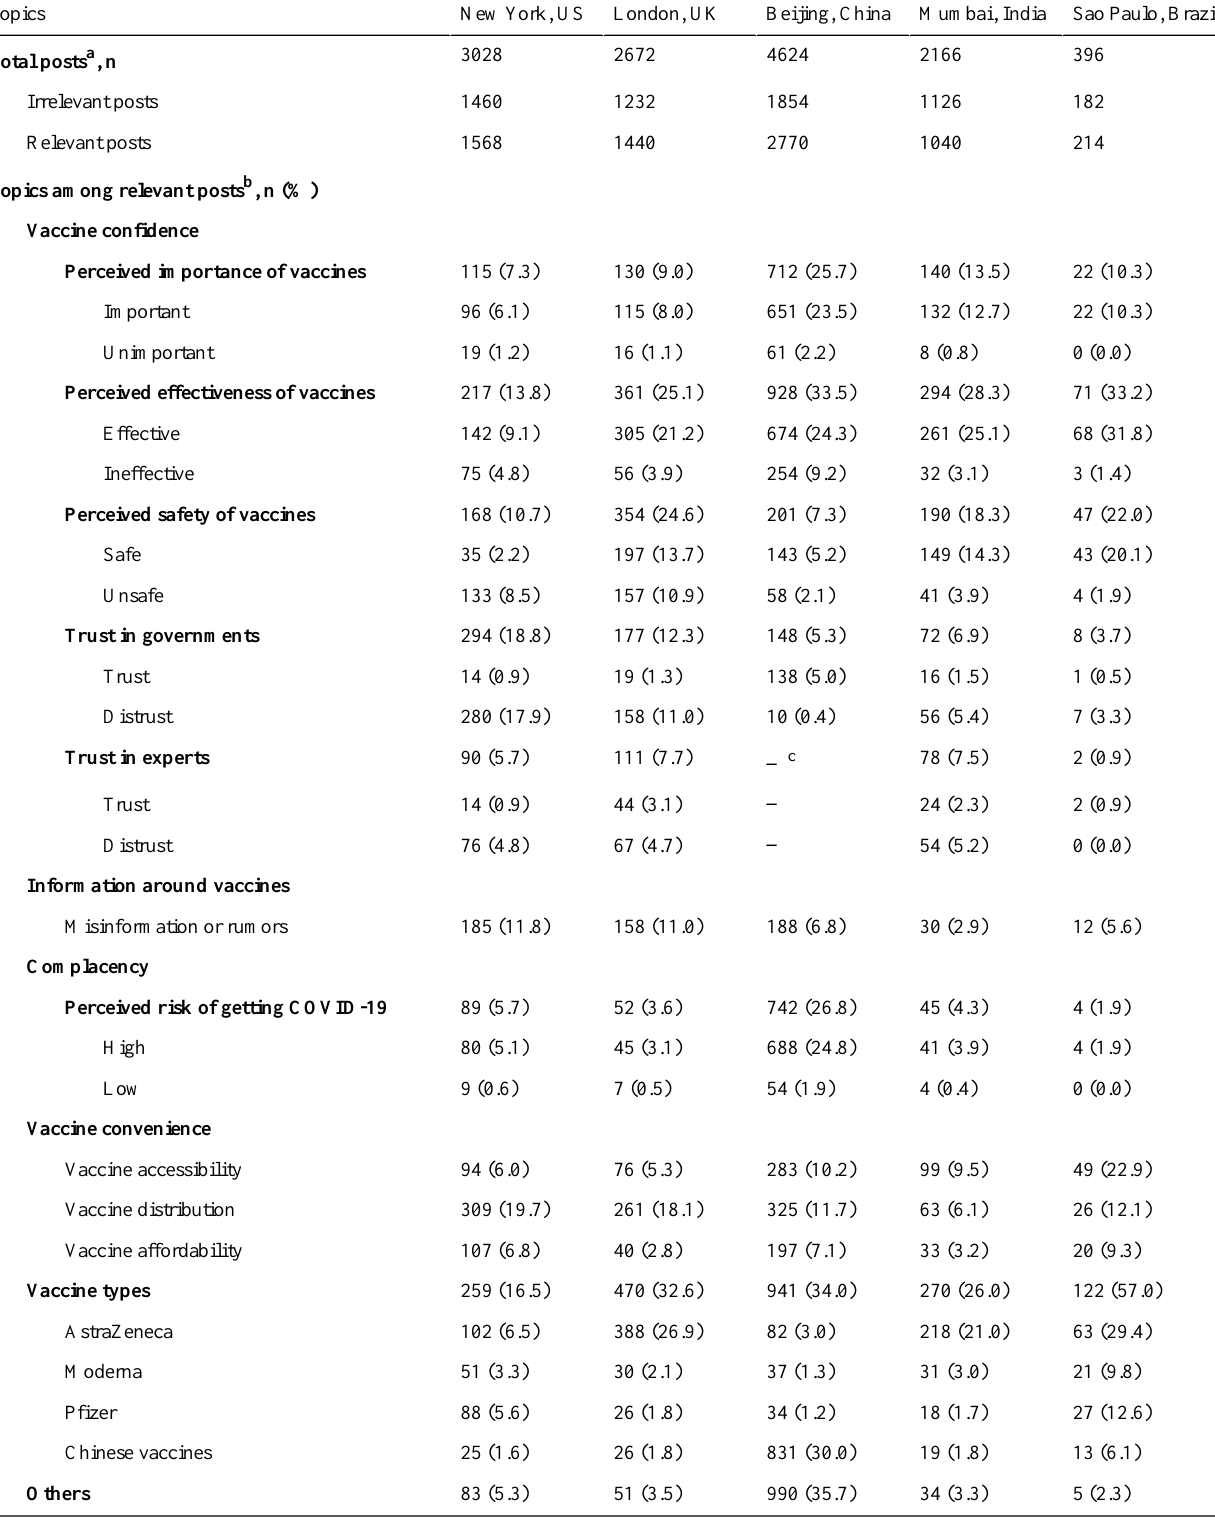
Table 1. Confidence, complacency, and convenience related to COVID-19 vaccines on social media in 2020.